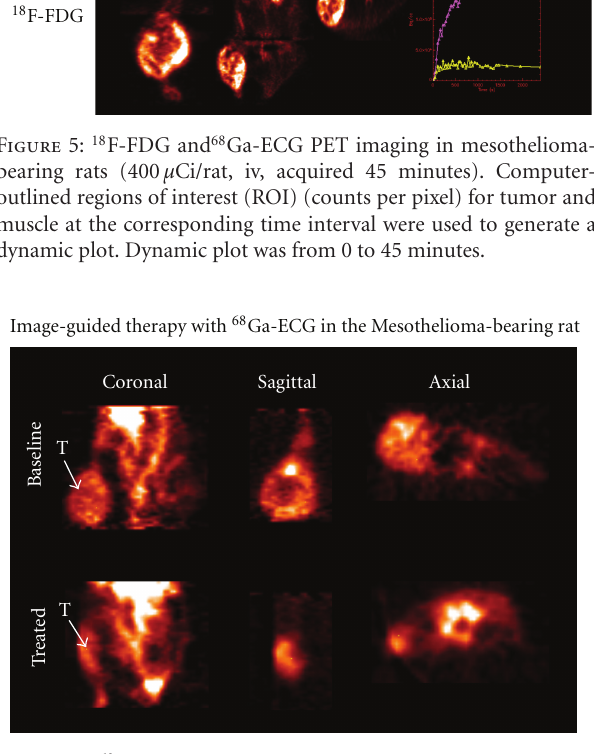
Figure 6: 68 Ga-ECG PET images in rat bearing mesothelioma (400 μ Ci/rat, iv, lower body) before and after treatment at 45 minutes. Top: baseline at tumor size 1.5cm; bottom: treated with paclitaxel (20mg/kg, iv, single dose on day 7). T: tumor.